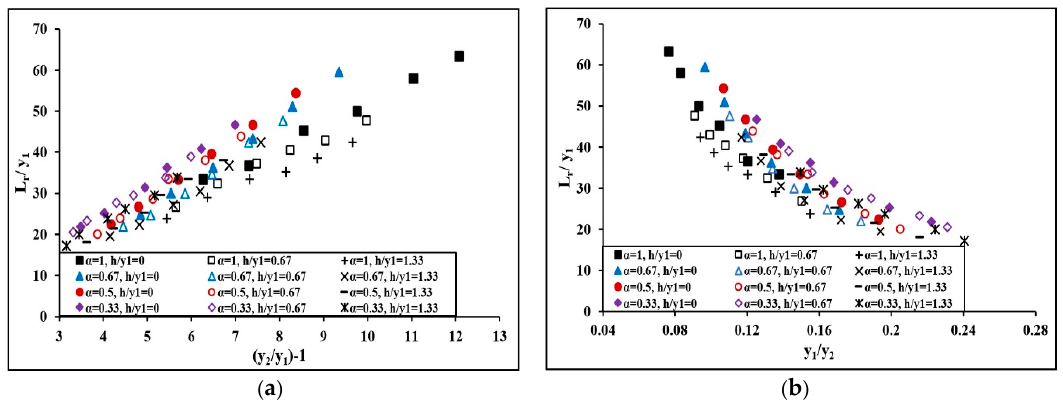
Figure 15. Relation between the ratio of L r / y 1 and ( a ) the di ff erence ( y 2 / y 1 − 1), ( b ) the ratio of ( y 1 / y 2 ) for the experimental data of this research.